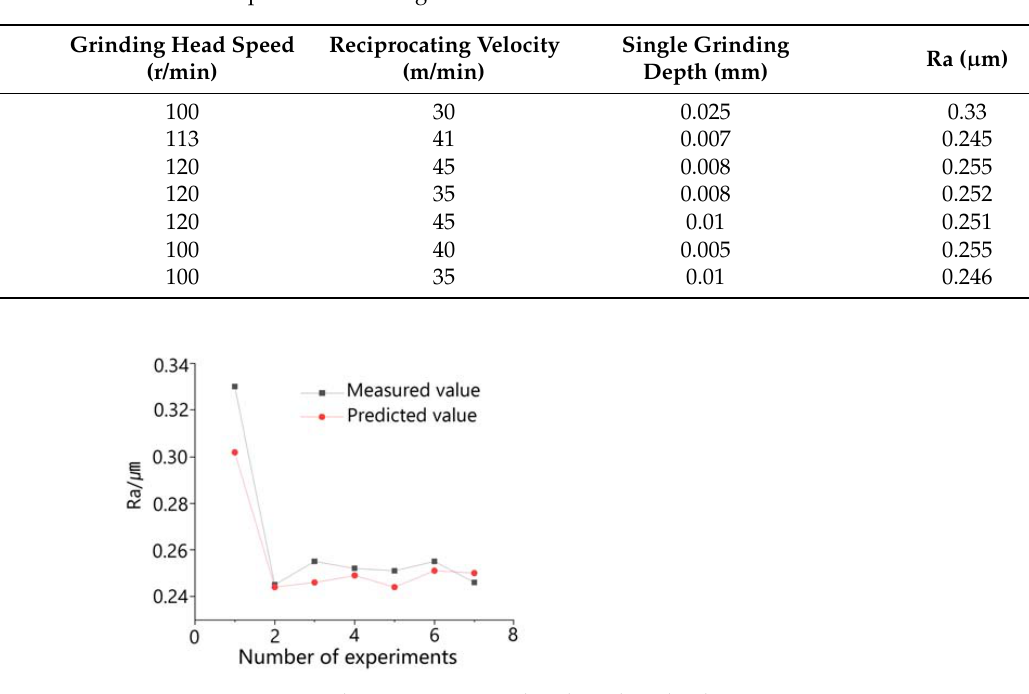
Figure 9. Comparison between measured and predicted value.